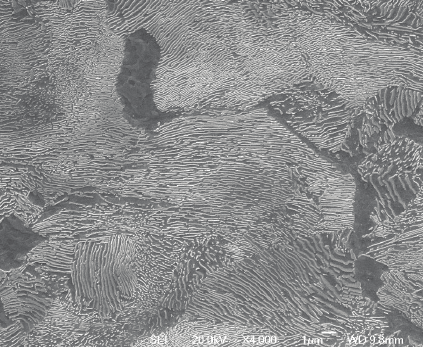
Figure 22: SEM image of pearlite lamellae in Region 1 of the wheel.